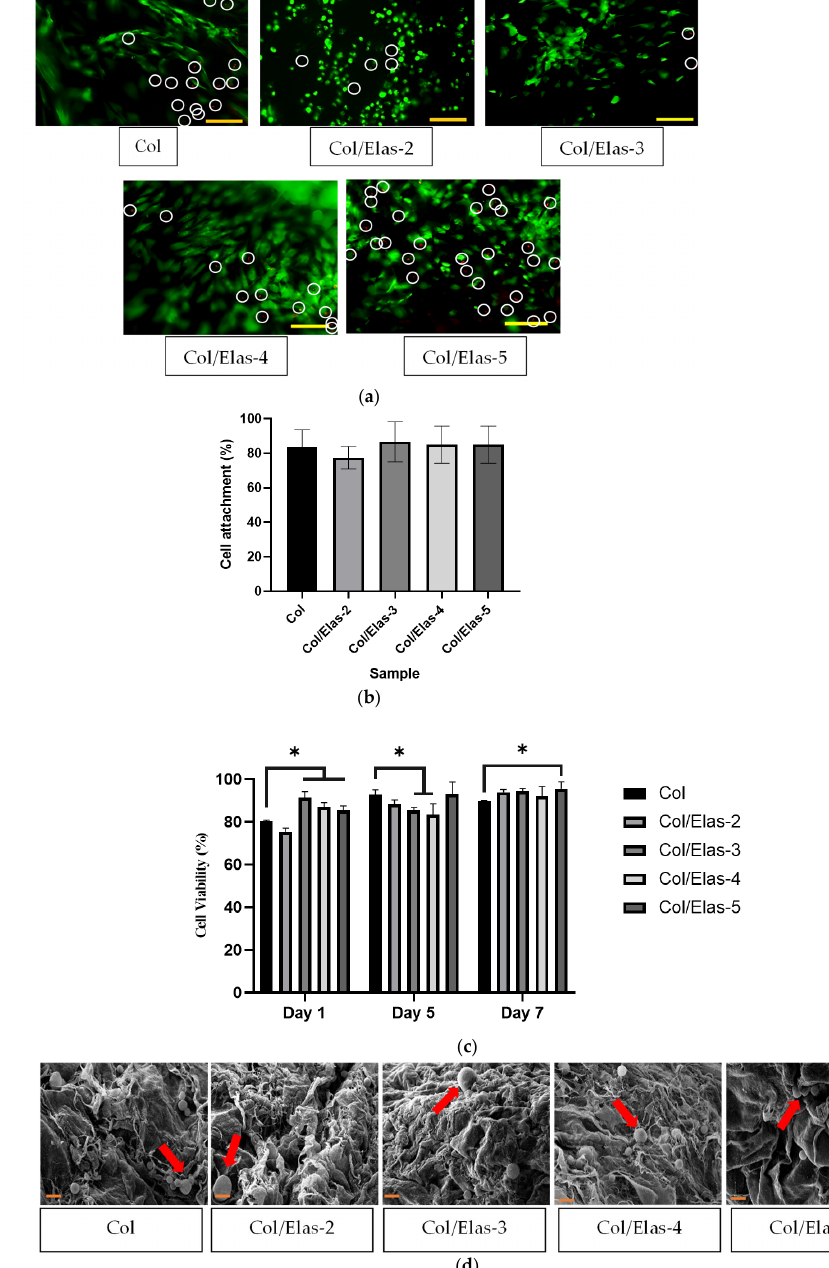
Figure 4. Cell-sca ff old interaction in 3D sca ff olds. ( a ) Live/Dead assay of the fabricated sca ff olds; Figure 4. Cell-scaffold interaction in 3D scaffolds. ( a ) Live/Dead assay of the fabricated scaffolds; Scale bar: 100 µm. ( b ) The quanti fi cation of cell a tt achment at 24 h. ( c ) Cell viability of HDF on the Scale bar: 100 µ m. ( b ) The quantification of cell attachment at 24 h. ( c ) Cell viability of HDF on the sca ff olds at day 1, 5 and 7 quanti fi ed by MTT assay. ( d ) Cross-sectional morphological features of HDF at 500× magni fi cation; Scale bar: 20 µm. (*) represents a signi fi cant di ff erence ( p < 0.05; n = 3) scaffolds at day 1, 5 and 7 quantified by MTT assay. ( d ) Cross-sectional morphological features of between fabricated sca ff olds. HDF at 500 × magnification; Scale bar: 20 µ m. (*) represents a significant difference ( p < 0.05; n = 3) between fabricated